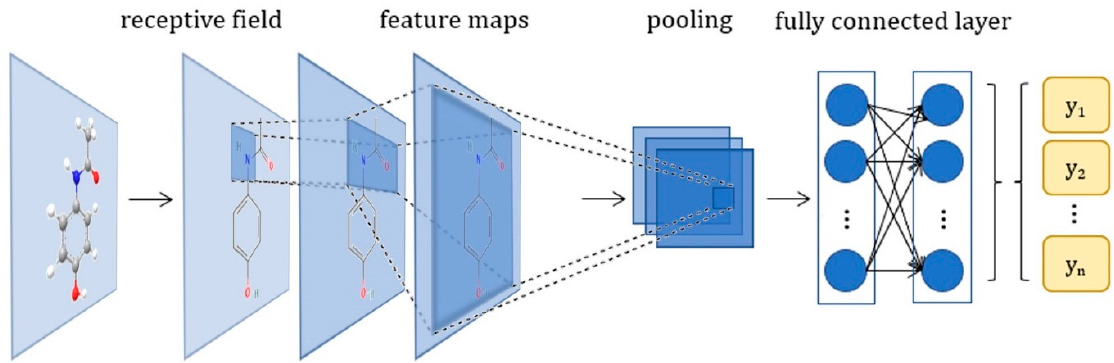
Figure 6. Schematic diagram of a CNN. A convolutional layer followed by a pooling layer forms a convolutional module. Each module learns to identify features while preserving spatial relationships. A fully connected layer is followed, which utilizes the output from the convolution process and predicts the class in a classification problem, based on the features extracted in previous stages.